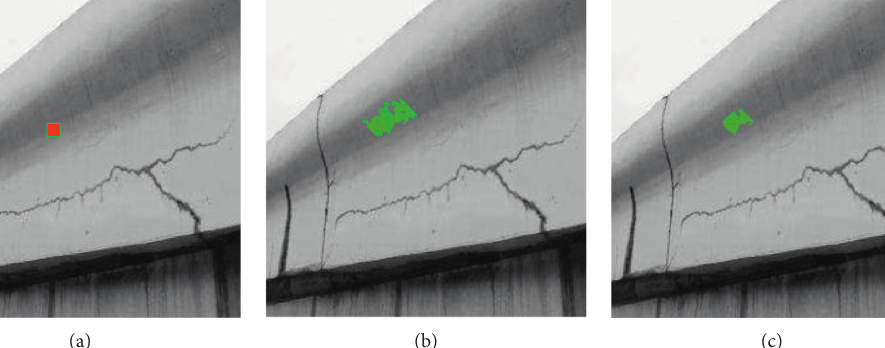
Figure 7: Percolation regions of pixel (100, 100) in image crack 3: (a) raw image; (b) without termination; (c) with termination.